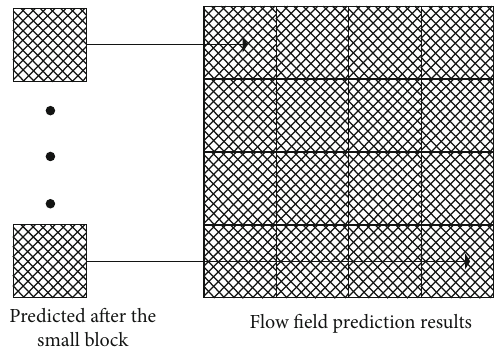
Figure 4: In the postprocessing phase, the predicted patches coordinates are used to reconstruct the patches data back to the 2D